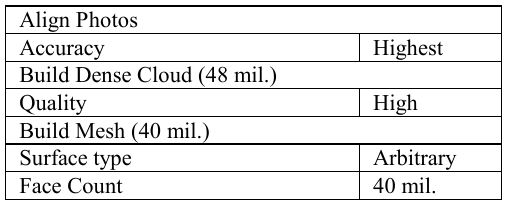
Table 6. Parameters of Agisoft Photoscan processing